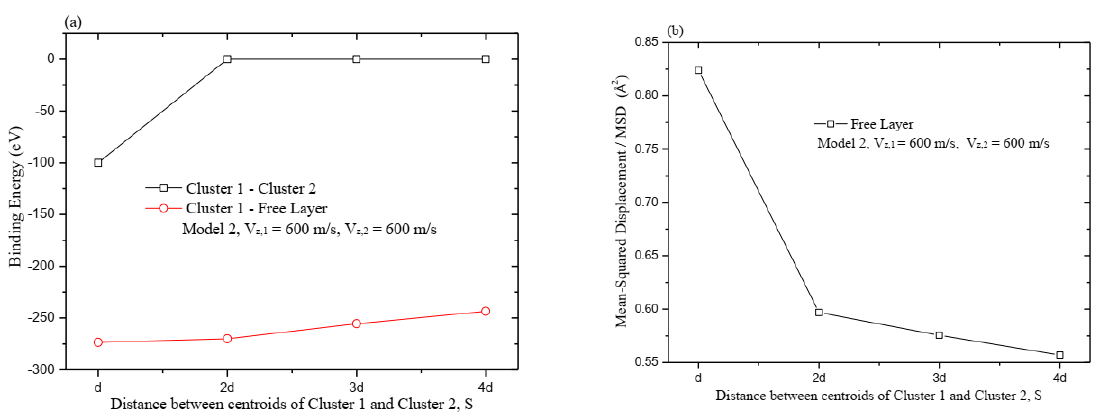
Figure 13. ( a ) Binding energy between Cluster 1 and Cluster 2 (or free layer) at different S. ( b ) MSD of free layer at different S. In all cases, V z ,1 = 600 m/s and V z ,2 = 600 m/s.